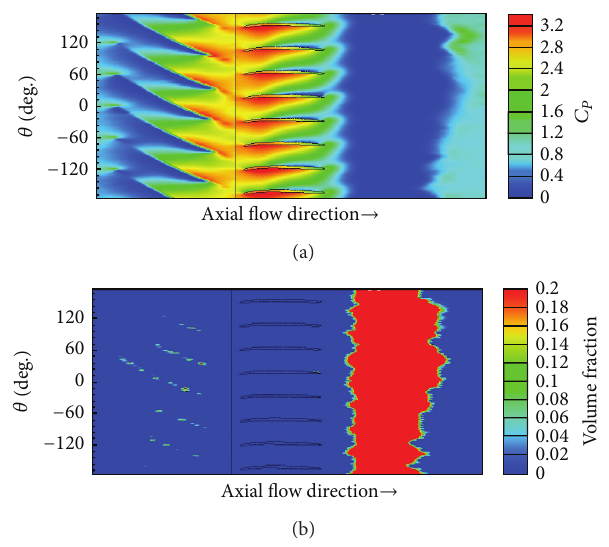
Figure 11: Pressure coefficient (a) and volume fraction of vapor (b) contours along the wall pump casing in the rotor, stator, and nozzle